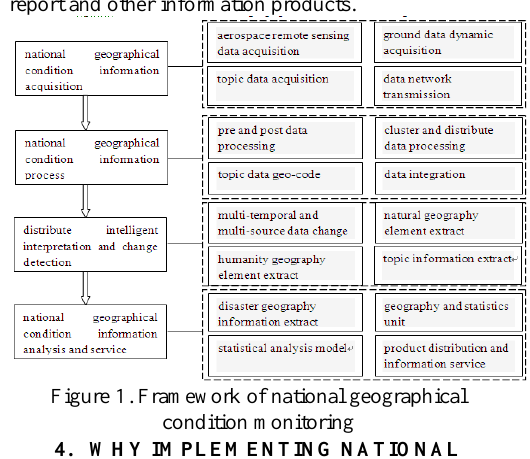
Figure 1. Framework of national geographical condition monitoring